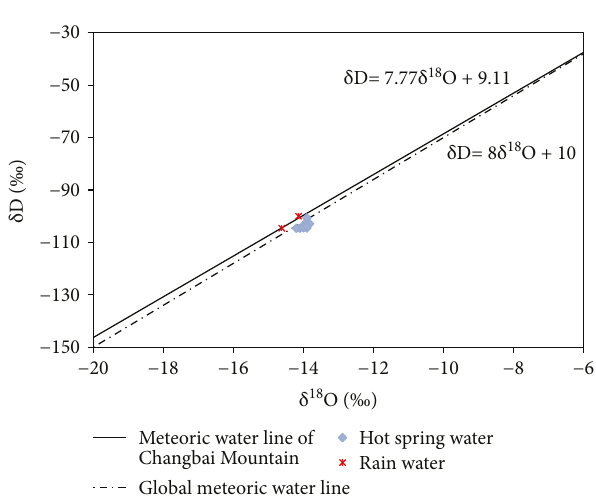
Figure 7: Relationship of δ 18 O- δ D of the hot spring